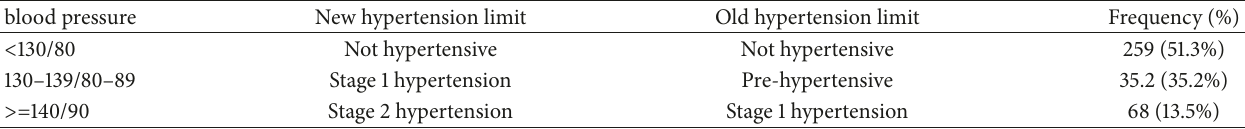
Table 2: Detailed frequencies for each hypertensive category.